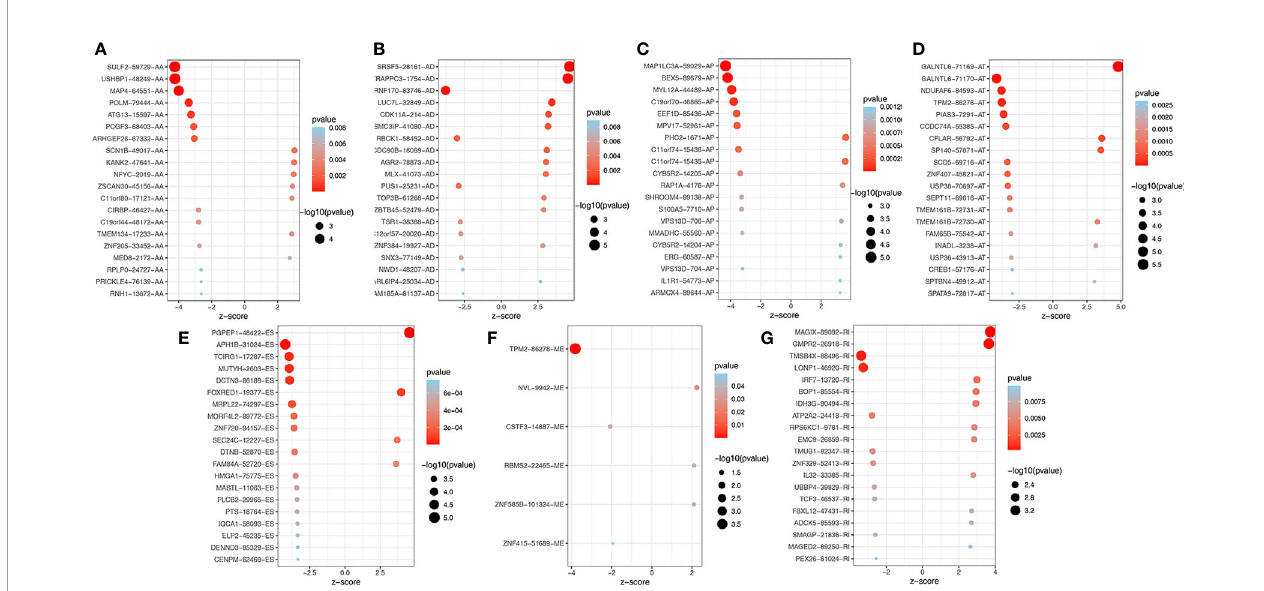
FIGURE 3 | Bubble plots of top 20 signi fi cant prognostic AS events in AA (A) , AD (B) , AP (C) , AT (D) , ES (E) , ME (F) and RI (G) type, respectively. AA, alternate acceptor site; AD, alternate donor site; AP, alternate promoter; AT, alternate terminator; ES, exon skip; ME, mutually exclusive exons; RI, retained